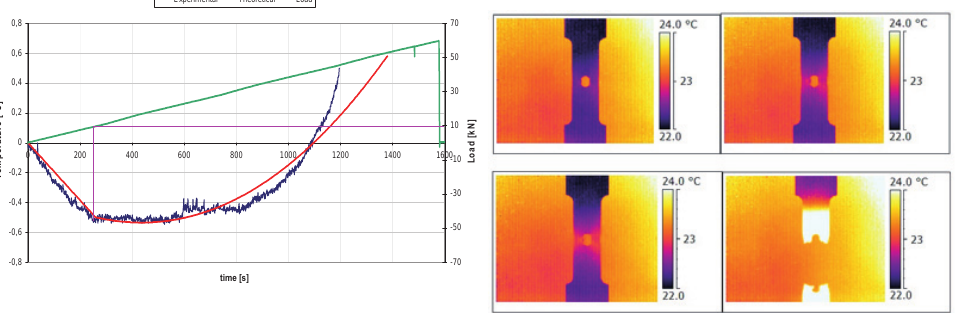
Fig. 6. Temperature evolution curves . Fig. 8. Thermographic images of the